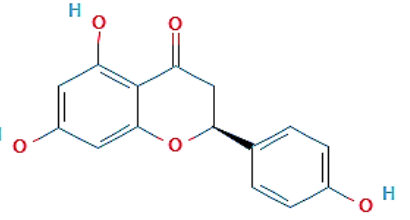
Figure 1. Chemical structure of naringenin ( Á lvarez- Á lvarez et al. [34]).